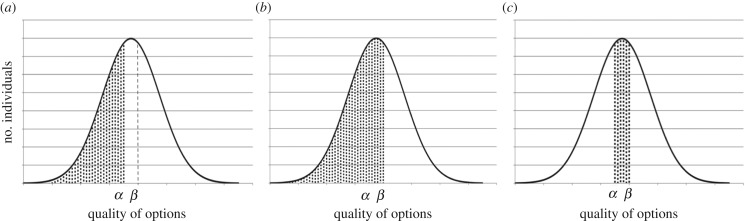
Majority-making mechanism for two options (each of a different quality) by a group comprising units with variable yes/no thresholds. Each option has a quality α or β (α < β), and the number of ‘yes’ response units for each option is the shaded area in (a) and (b), respectively. The number of ‘yes’ response units is larger for option β than for option α (the shaded area in (c)). As a result, option β (the better option) is always selected by a collective decision-maker using the majority decision.